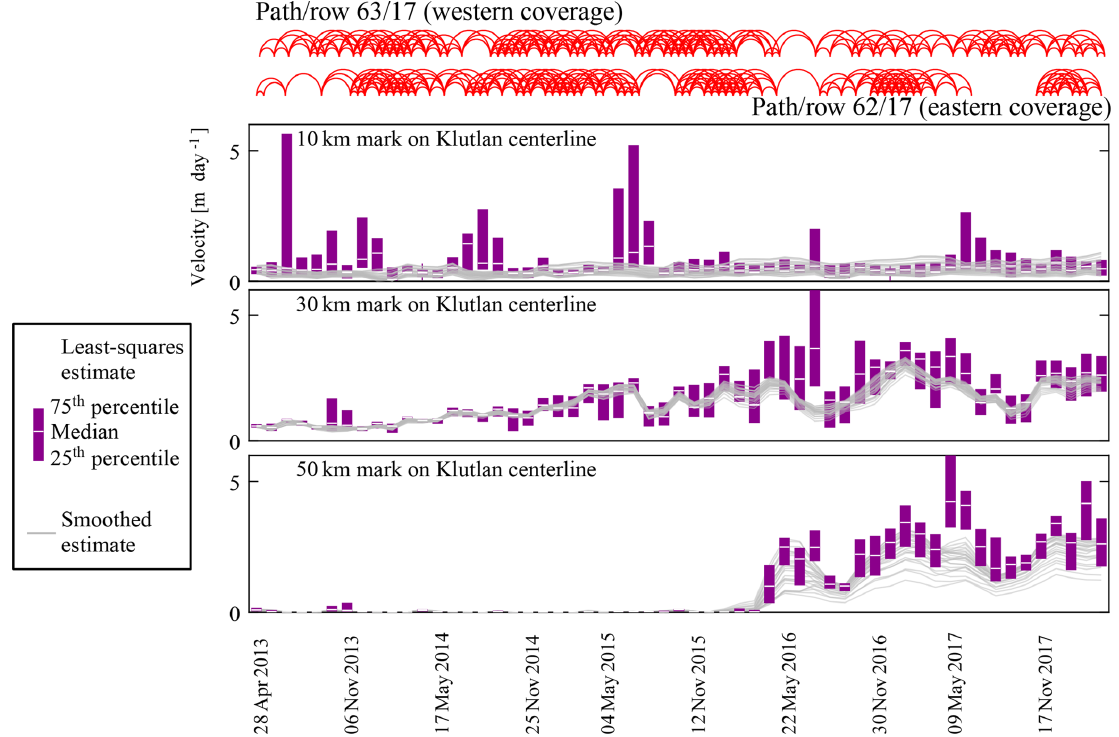
Figure B1. Temporal evolution of three locations along the flow line of Klutlan Glacier. The data from the specific marker and its direct neighborhood are shown. In purple is the box plot of these data while in gray the smoothed estimates are plotted. For the location of the reference marks, please see Fig. 11a. Above the figures, the network configuration of the GoLIVE data for the two covering Landsat scenes is